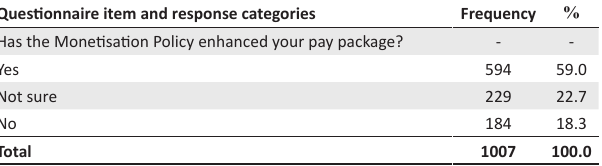
TABLE 1-A1: Respondents’ views on the effect of the Monetisation Policy on employee pay packages. Questionnaire item and response